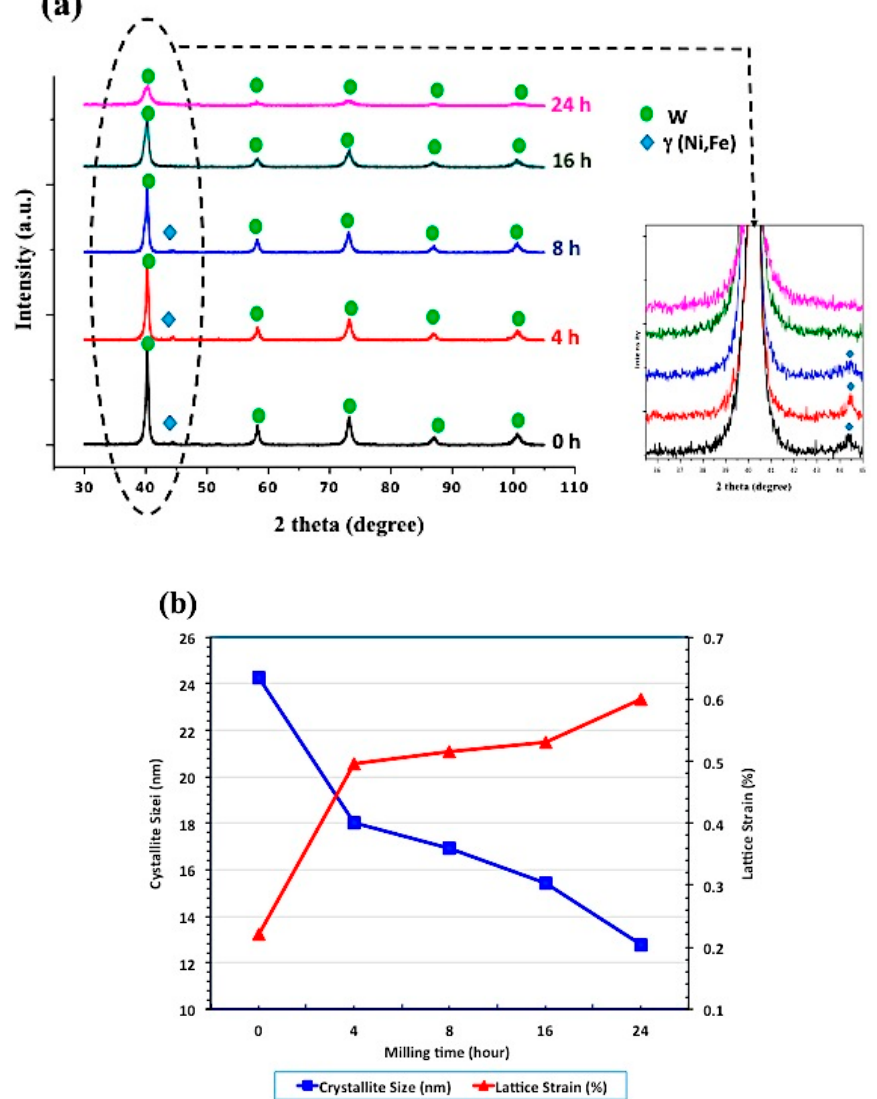
Figure 2. ( a ) XRD spectra of the W-Mo matrix/ γ -Ni(Fe,Co) binder powders milled for 0 h, 4 h, 8 h, 16 h, and 24 h; ( b ) crystallite size and lattice distortion of the W-Mo matrix/ γ -Ni(Fe,Co) binder powders milled as a function of milling time.